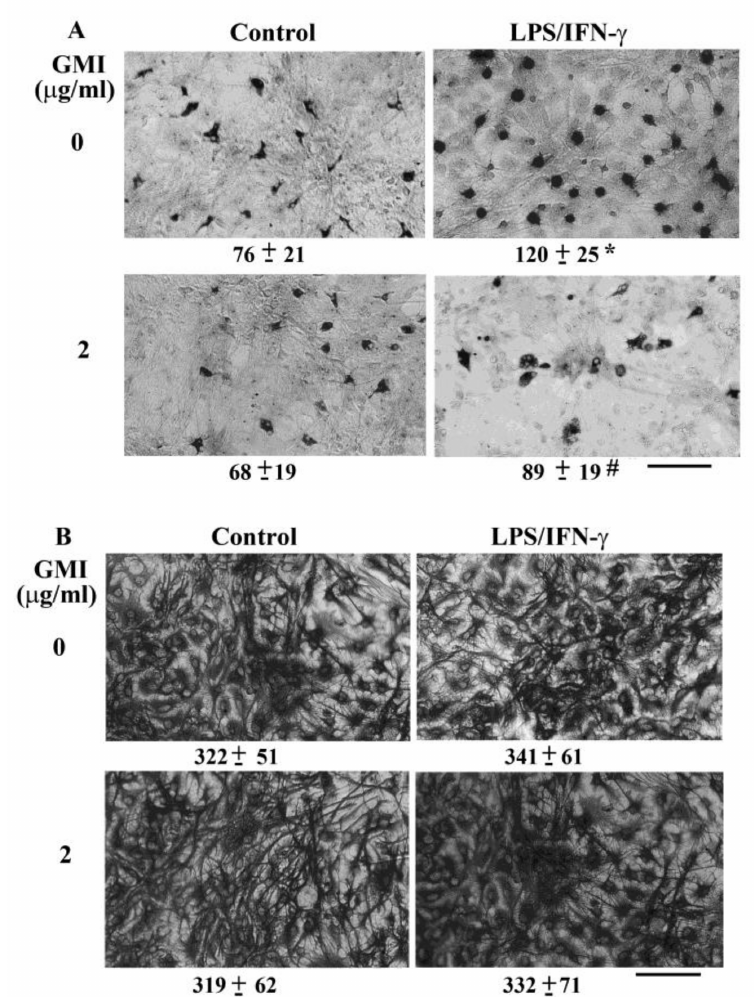
Figure 2. GMI alleviated microgliosis. Neuron/glia cultures were pretreated with vehicle or GMI (2 µ g/mL) for 30 min before being incubated with LPS (100 ng/mL)/IFN- γ (10 U/mL) for an additional 48 h. Microglia ( A ) and astrocytes ( B ) were examined by immunocytochemical staining of CD68 and GFAP, respectively. Representative micrographs and quantitative numbers are shown. Bar, 60 µ